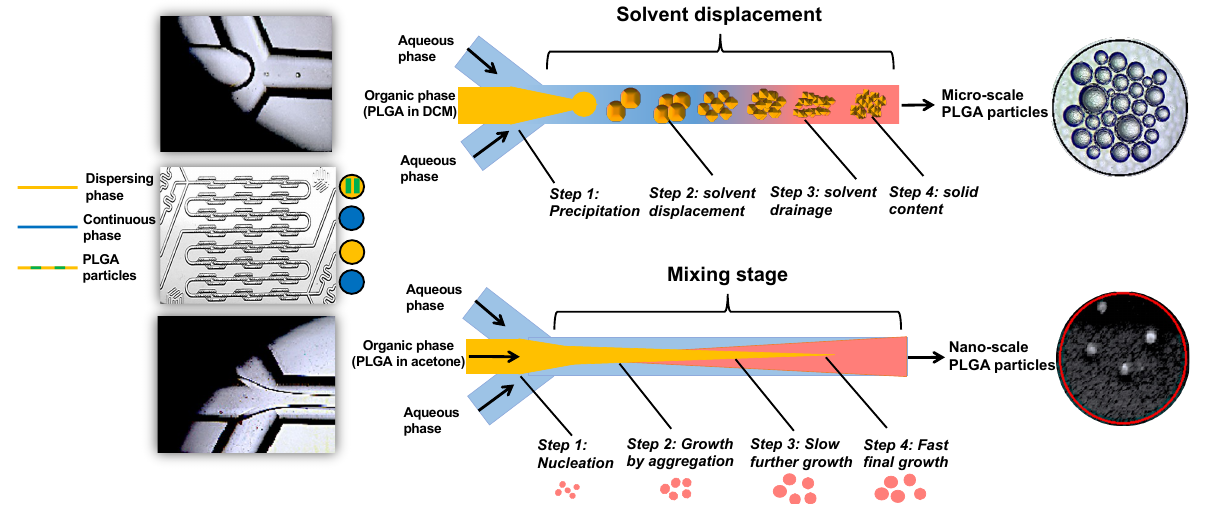
Figure 1. A schematic diagram of the microfluidic chip used (hydrophilic micromixer) and the process of the formulation of micro and